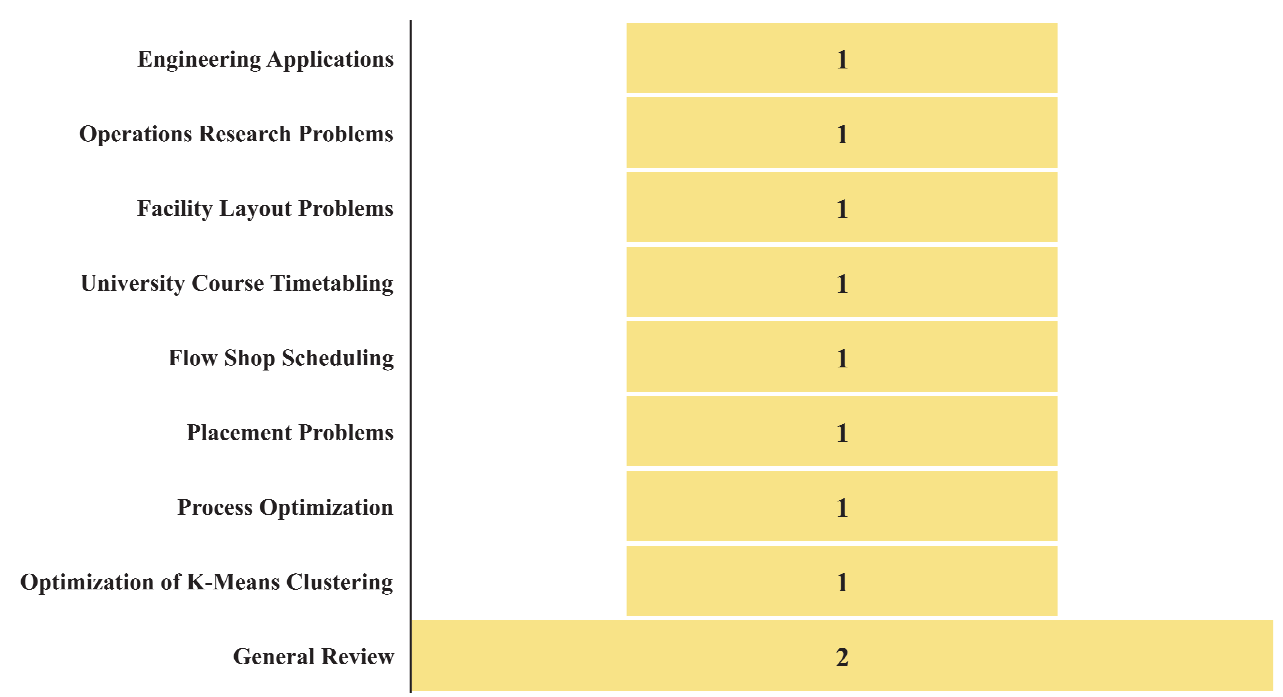
Figure 3: Number of review papers on different applications of